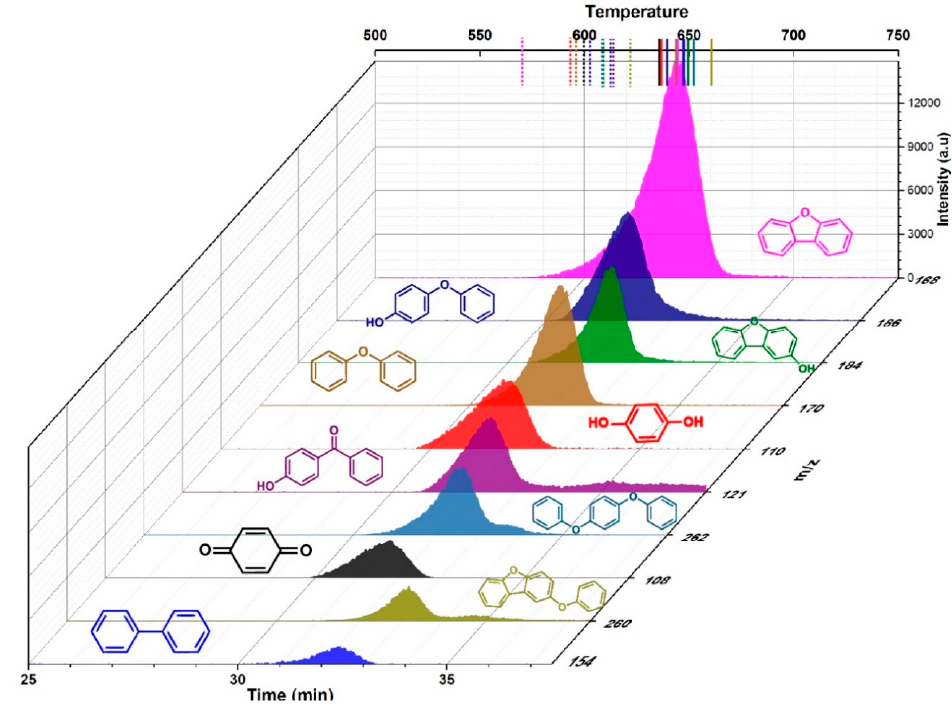
Figure 6. Intensity profiles of biphenyl (blue), 2-phenoxydibenzo[b,d]furan (olive), benzoquinone (black), 4-diphenoxybenzene (pale blue), 4-hydroxybenzophenone (purple), hydroquinone (red), diphenylether (pale brown), dibenzo[b,d]furan-2-ol (green), 4-phenoxyphenol (Prussian blue) and